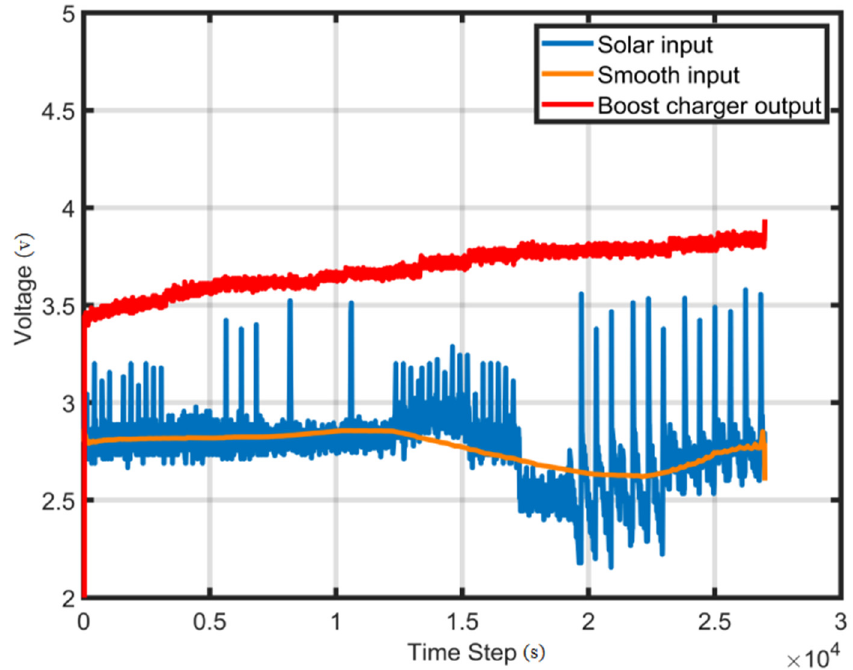
Figure 15. The measured open-circuit supercapacitor charging curve versus the solar input voltage (at 582 lux).